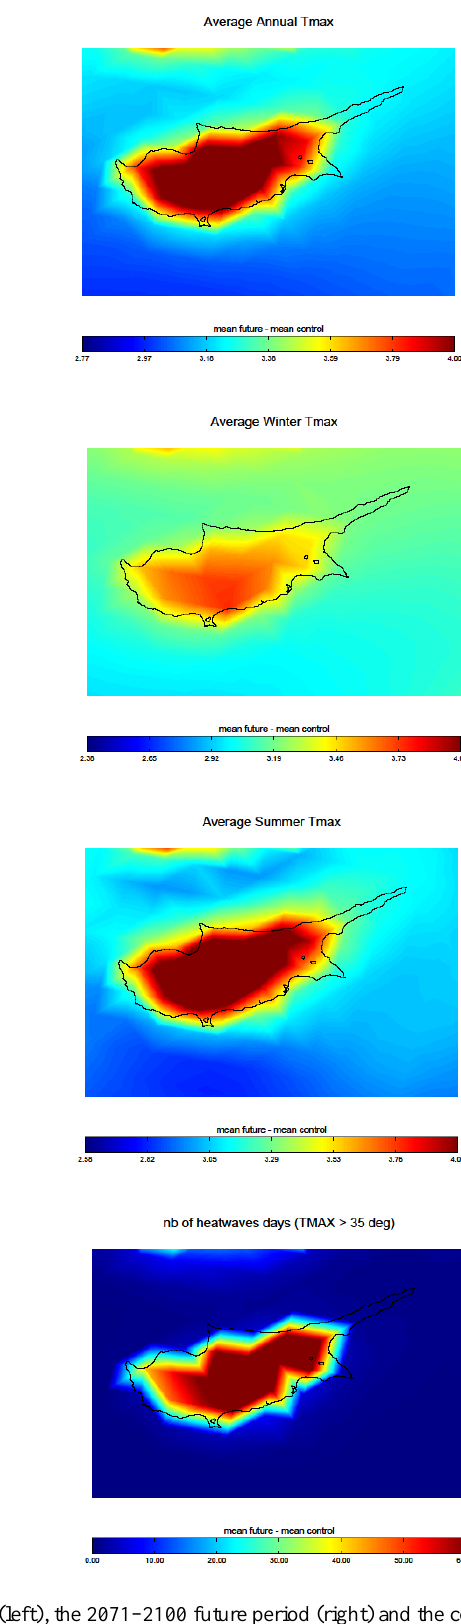
Fig. 2. Mean differences between the 2021–2050 future simulation (left), the 2071–2100 future period (right) and the control run period for the average annual T max , average winter T max , average summer T max , number of days with T max > 35 ◦